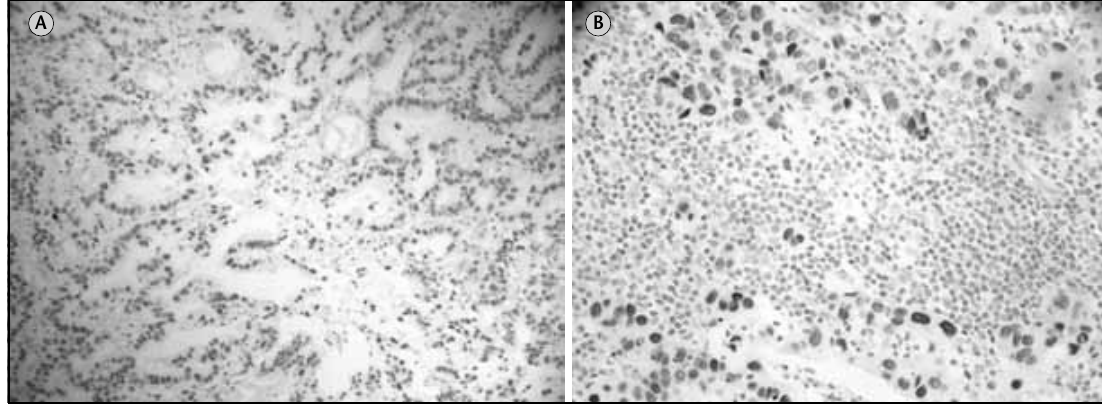
Figura – Presença de EBV em carcinoma gástrico detectada pela técnica de hibridização in situ. (A) Carcinoma do tipo intestinal de Lauren exibindo intensa marcação nuclear (400×); (B) carcinoma do tipo difuso de Lauren exibindo marcação nuclear intensa e difusa (600×). EBV: vírus